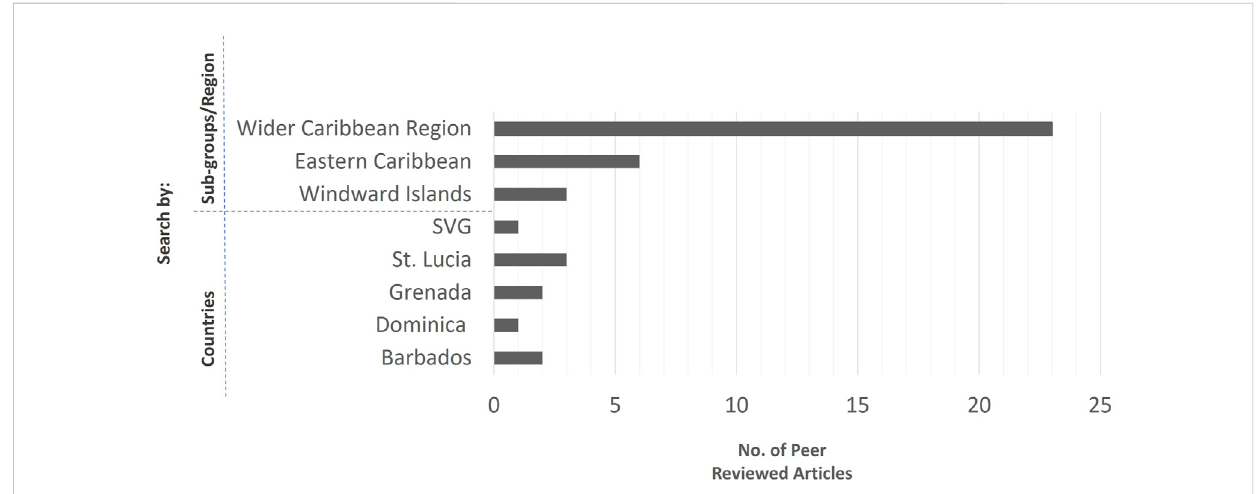
FIGURE 1 Number of relevant peer reviewed literature for the individual islands versus varying